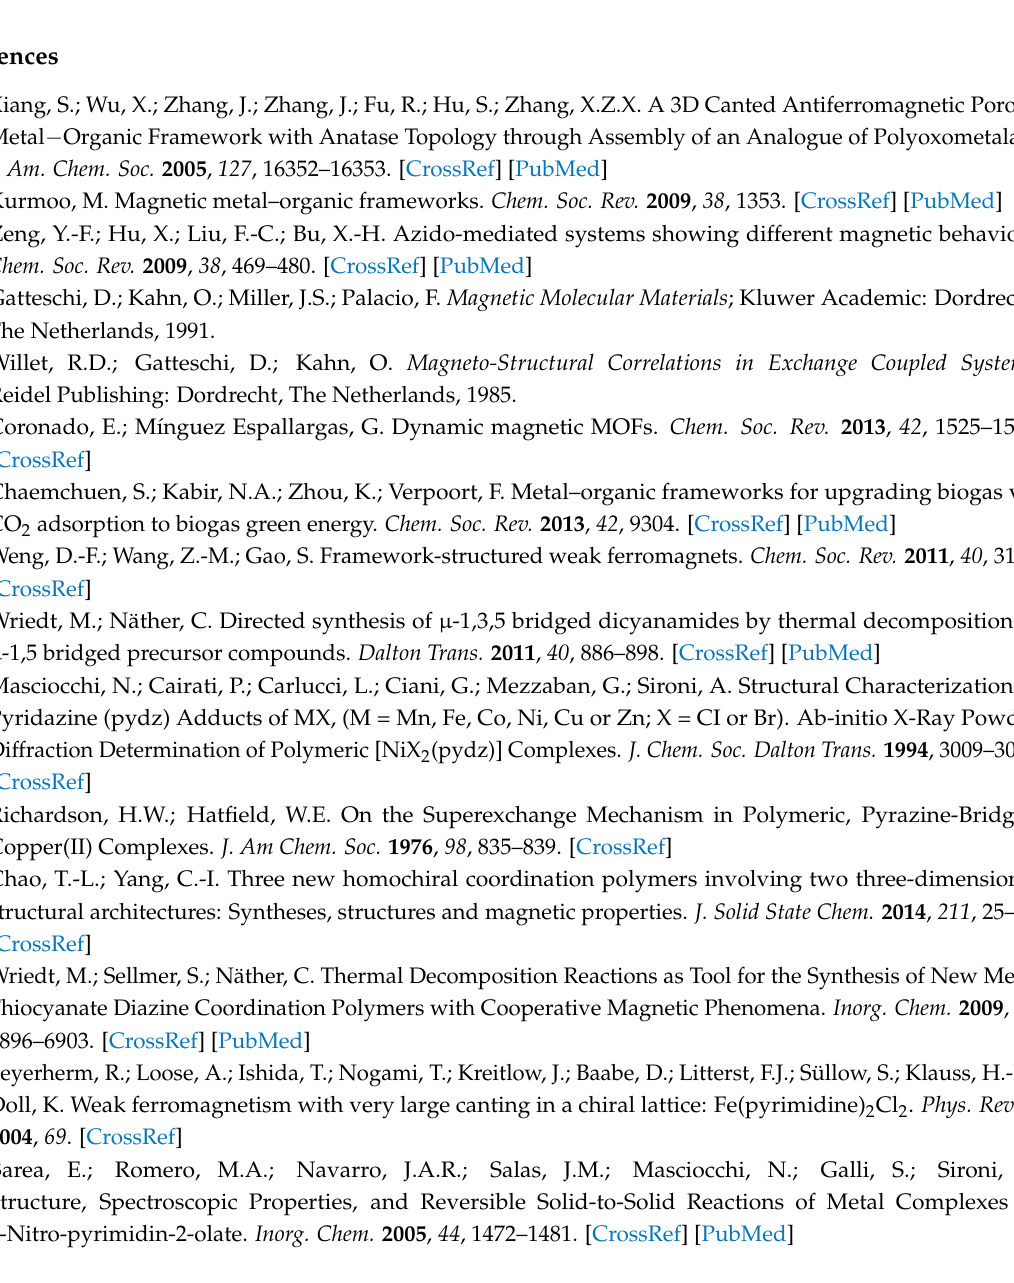
) vs. T for a ) vs. T for a powdered sample of compound 1 . (cid:35) (cid:35)